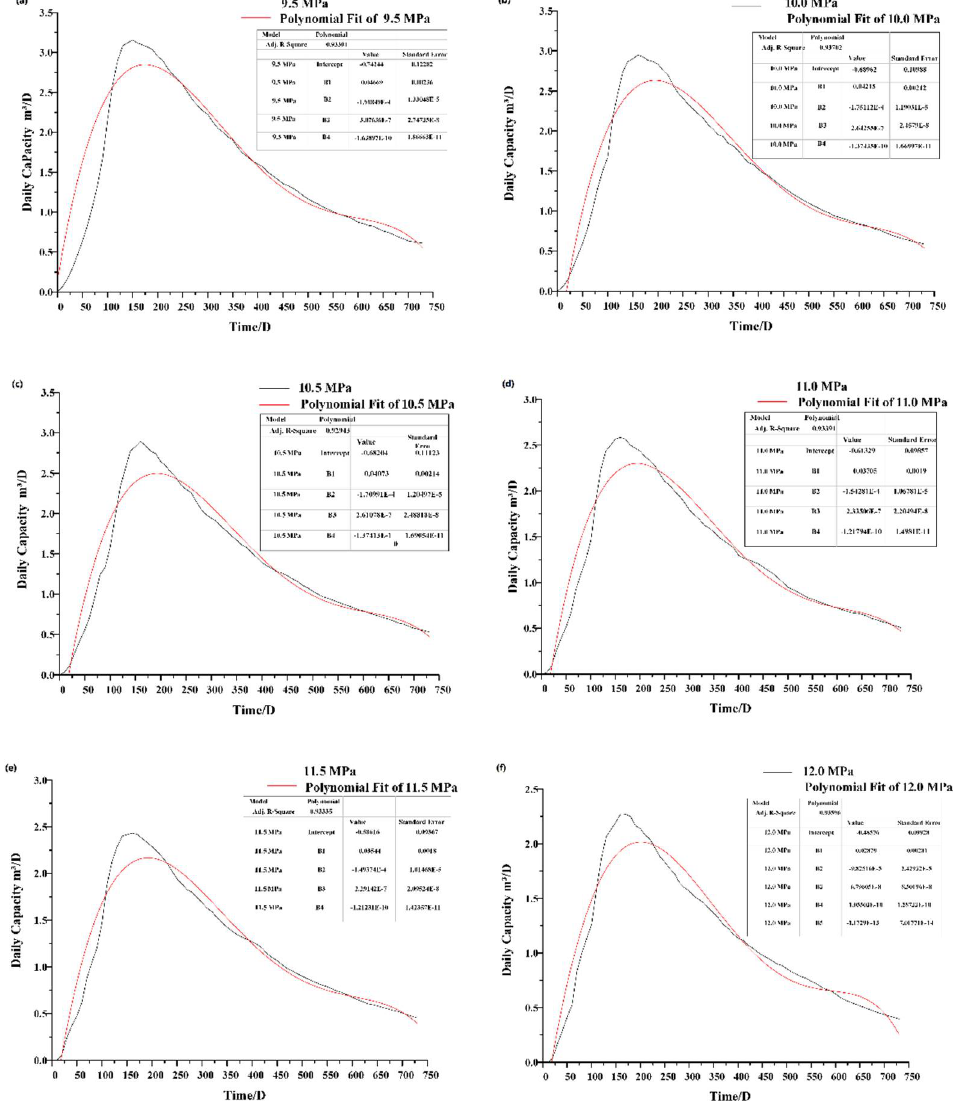
Figure 8. Influence of mining flow pressure on daily productivity. ( a ) 9.5 MPa ( b ) 10.0 MPa ( c ) 10.5 MPa ( d ) 11.0 MPa ( e ) 11.5 MPa ( f ) 12.0 MPa.